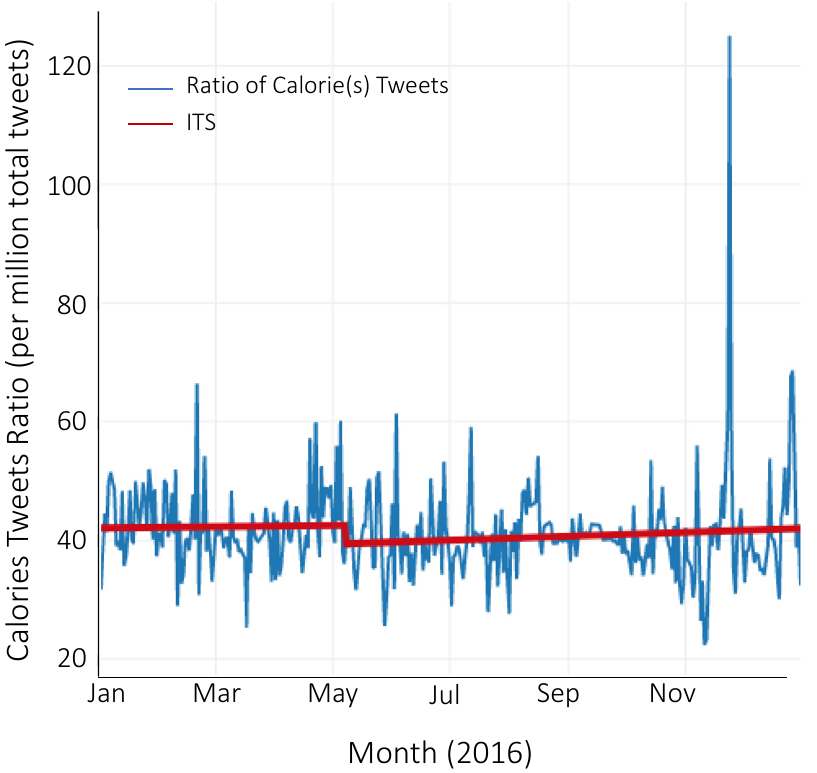
Figure 2. Interrupted time-series of the daily ratio of calorie(s) tweets in 2016. In 2018, Google Trends search queries for calories appeared fairly stable pre-imple- mentation but declined substantially post-implementation (Figure 3). Patterns were simi- lar in 2016, but search queries for calories were lower this year compared to 2018 and did not decline in the same pattern post-implementation. The ITS analysis showed a small, statistically significant upward trend of 0.0043 (SE = 0.036, p < 0.001) weekly search queries for calories pre-implementation, with no significant level change post-implementation